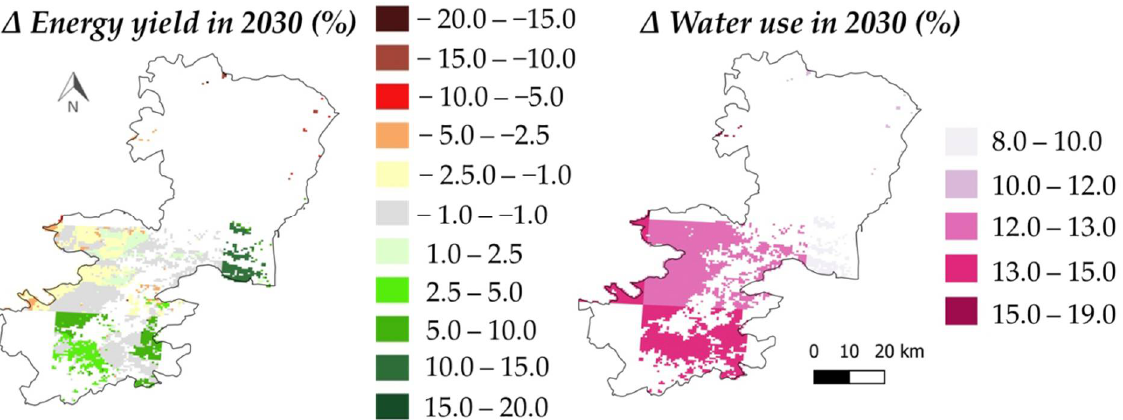
Figure 7. Projected impact of climate change on energy yield and natural water consumption in 2030 in the province of Catania. The results are shown, for each simulation unit, as percentage difference compared to the baseline.